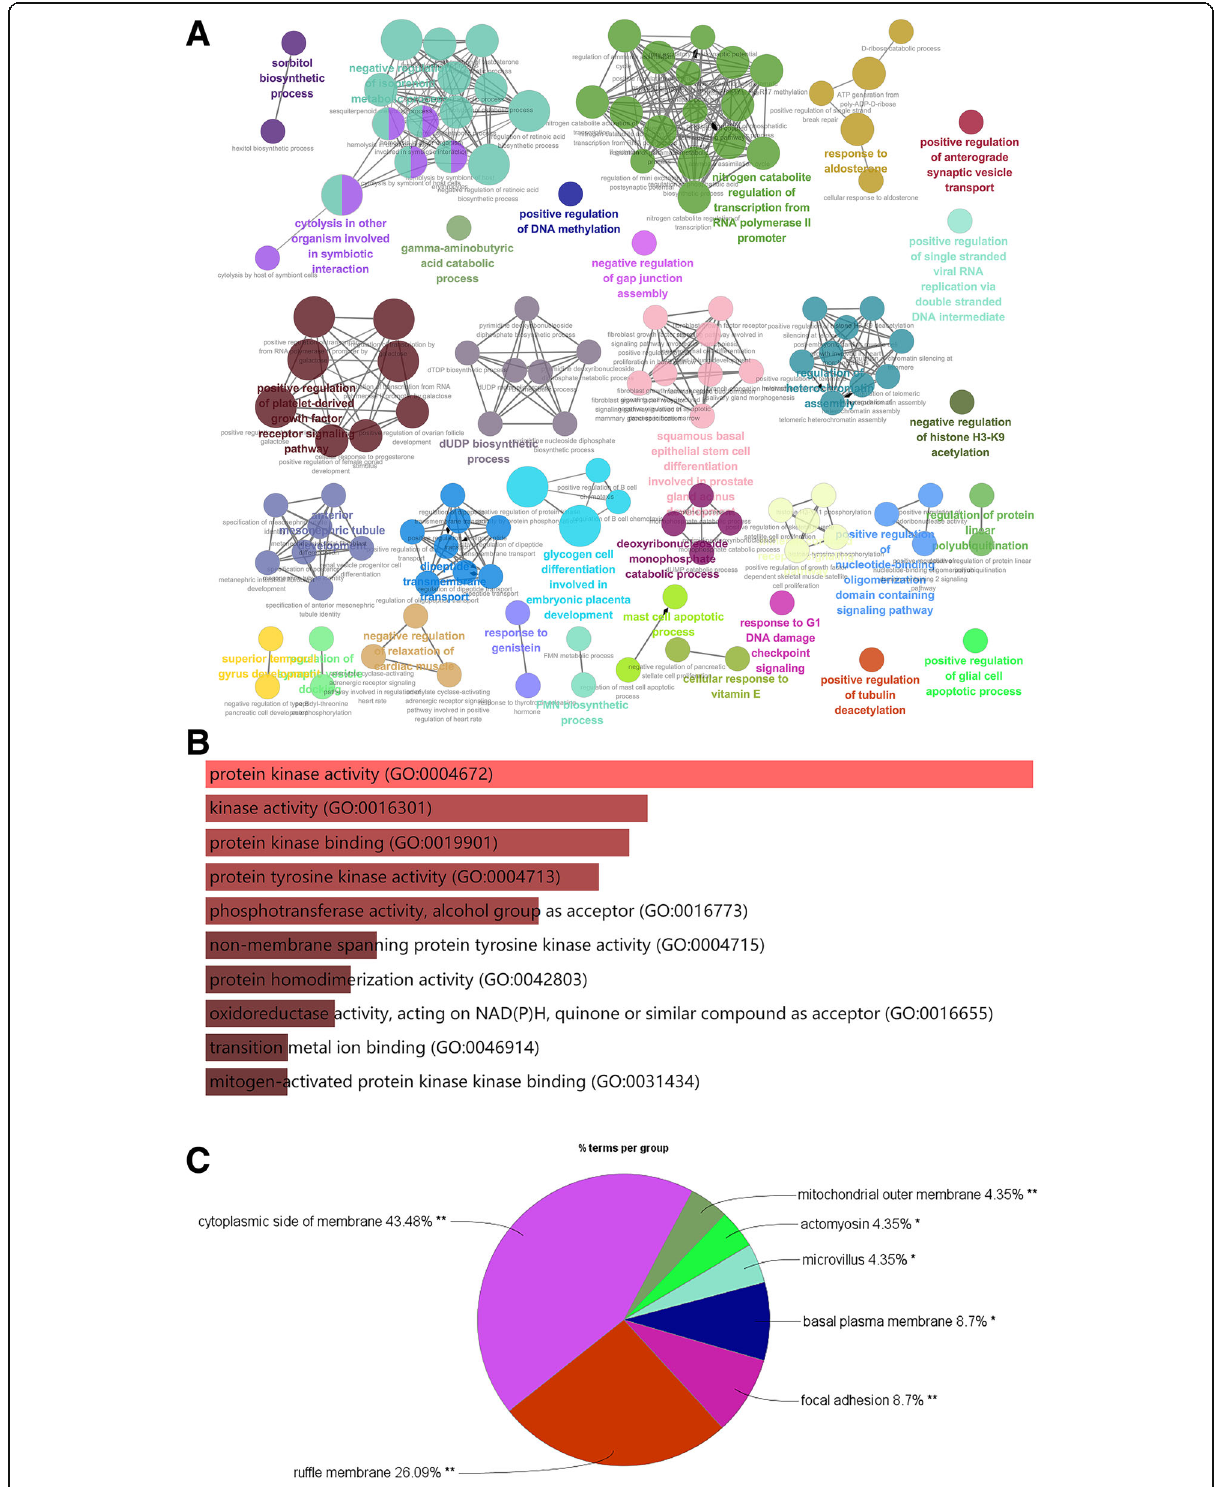
Fig. 2 The GO analysis of predicted targets of TRX. Enrichr analysis was performed to identify the most significantly enriched GO terms. The enriched biological process terms ( a ), molecular function terms ( b ) and cellular component ( c ) were listed based on the P